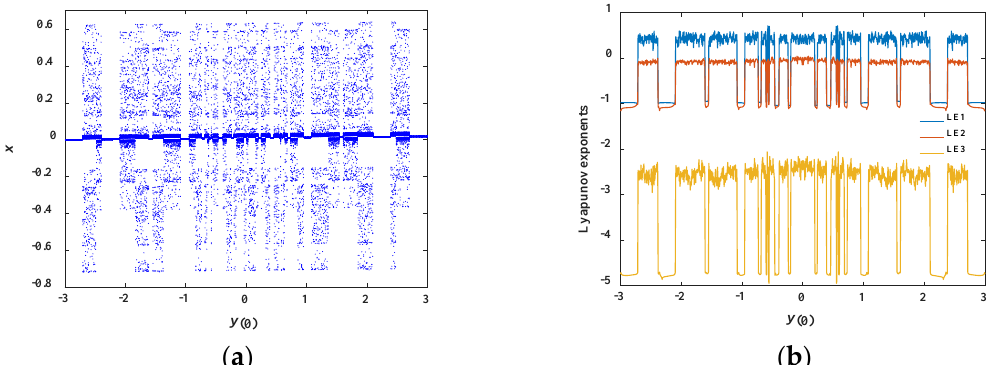
Figure 14. Dynamics of the system with y (0) ∈ (-3, 3): ( a ) bifurcation diagram; ( b ) Lyapunov exponents.